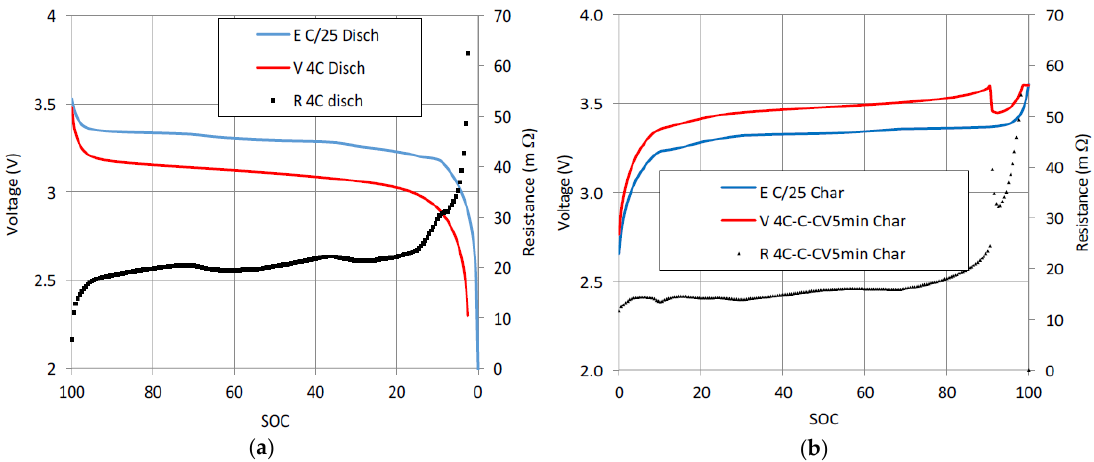
Figure 2. ( a ) Internal resistance evolution profile versus state of charge of the cell, 4C discharge; and ( b ) 4C-1C-CV 5 min charge.